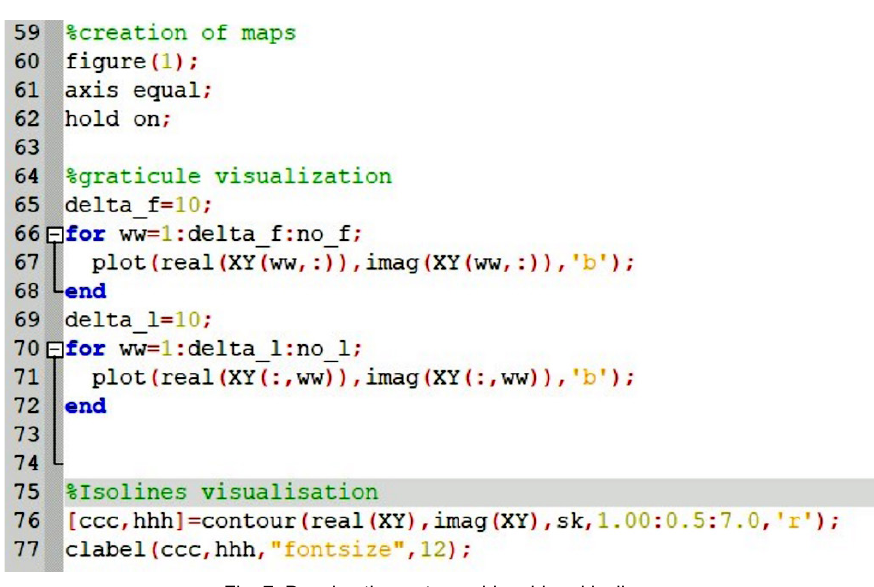
Fig. 7. Drawing the cartographic grid and